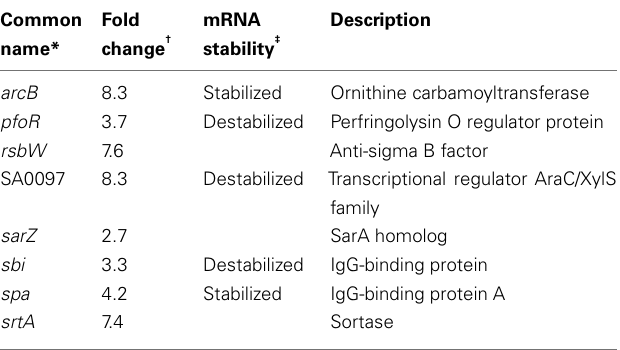
Table 6 |Virulence-associated transcripts bound by cellular